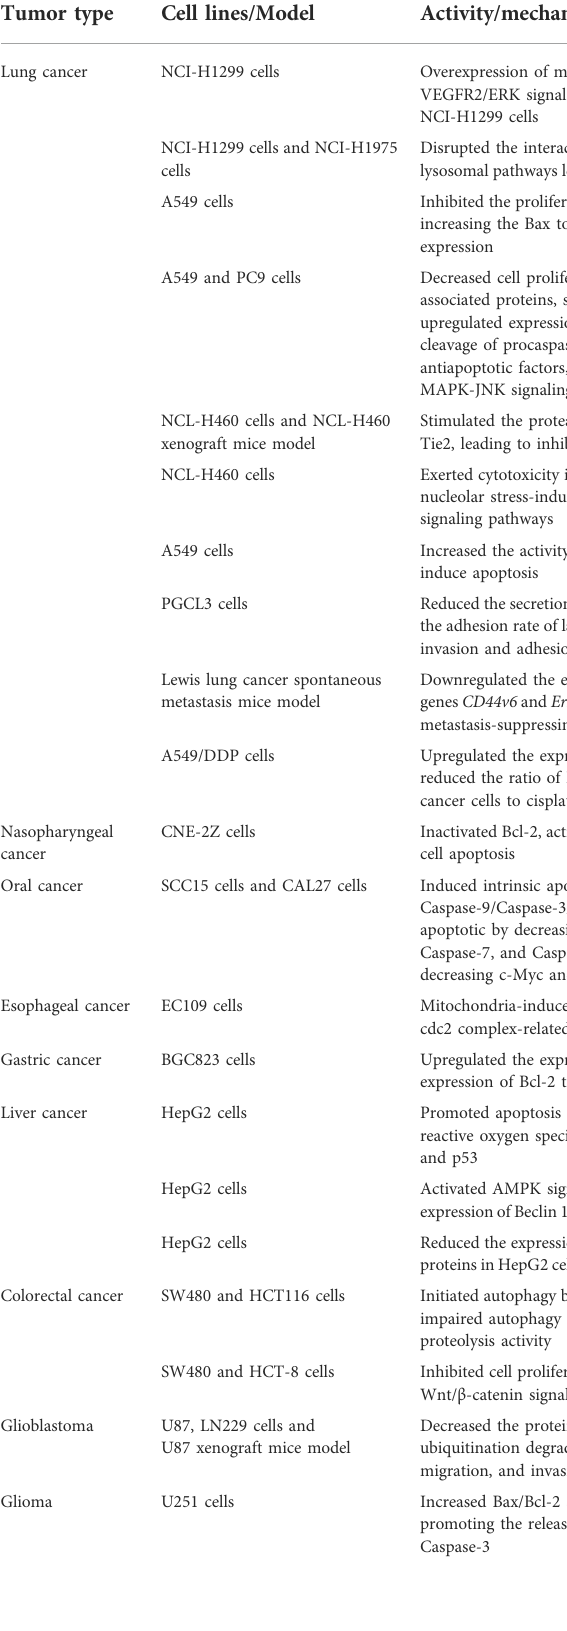
TABLE 2 Antitumor activity of